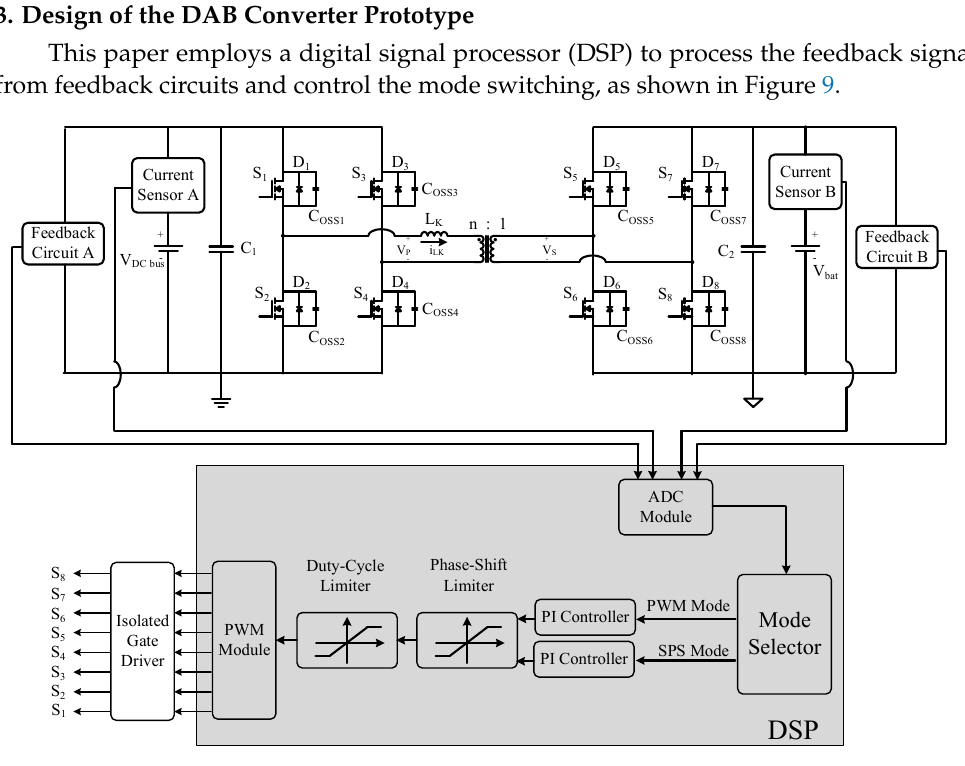
Figure 9. Block diagram of the proposed dual-mode control for the DAB converter.